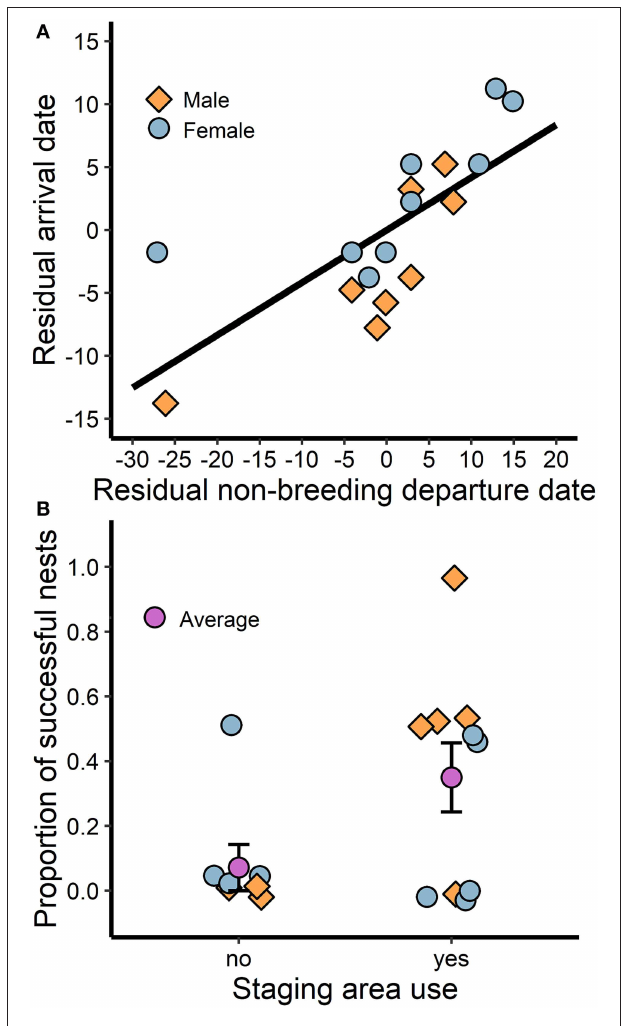
FIGURE 4 | The association between spring migration behavior and breeding success: (A) individuals that depart the last stationary site (i.e., staging area or winter site) later arrive late to the breeding site, and (B) individuals that use staging areas in the Thompson-Okanagan or northern Columbia Plateau regions en route to the breeding site have greater breeding success. Residual date was calculated by subtracting from the mean such that positive values are delayed and negative values are